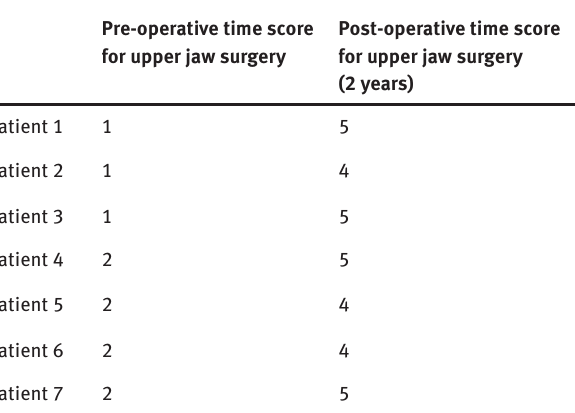
Table 3: Aesthetic evaluation at lower jaw of 3 patients selected at pre-operative and post-operative (2 years) time following Likert